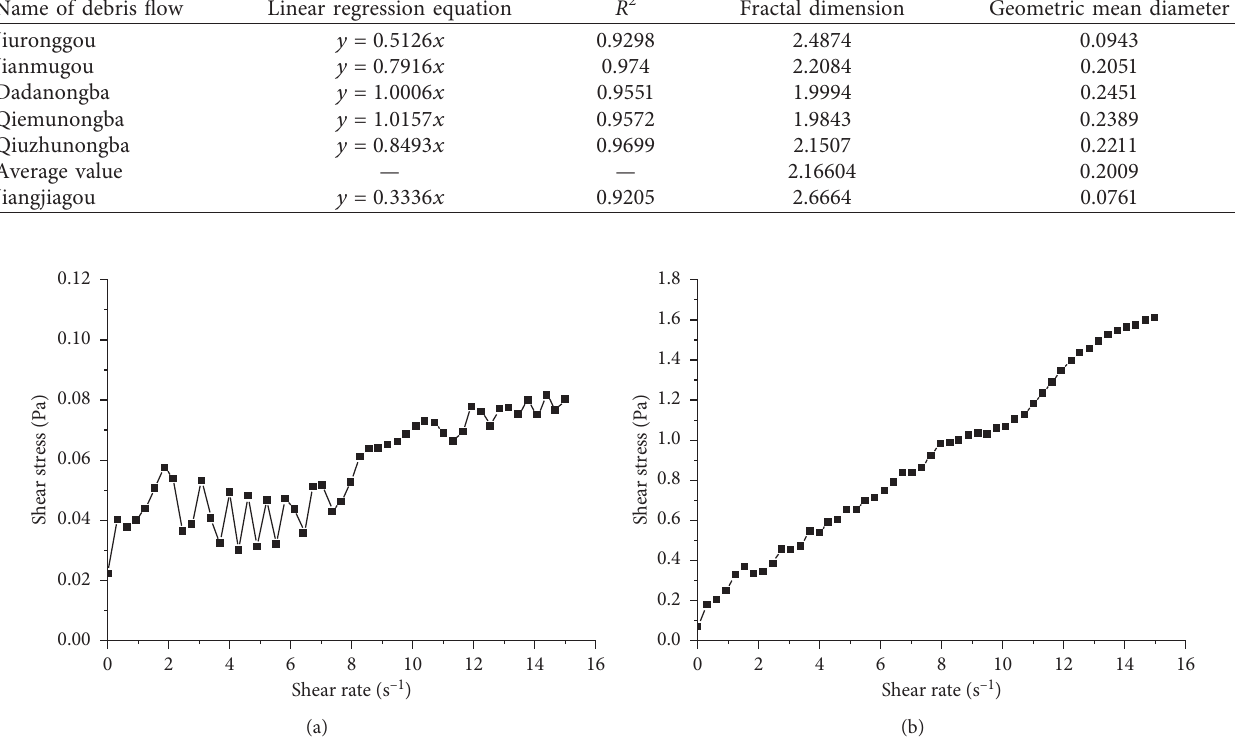
Figure 8: Rheological curves of debris flow. (a) Guxiang gully (bulk weight 13kN/m 3 ). (b) Qiuzhu Nong (bulk weight 18kN/m 3 ).